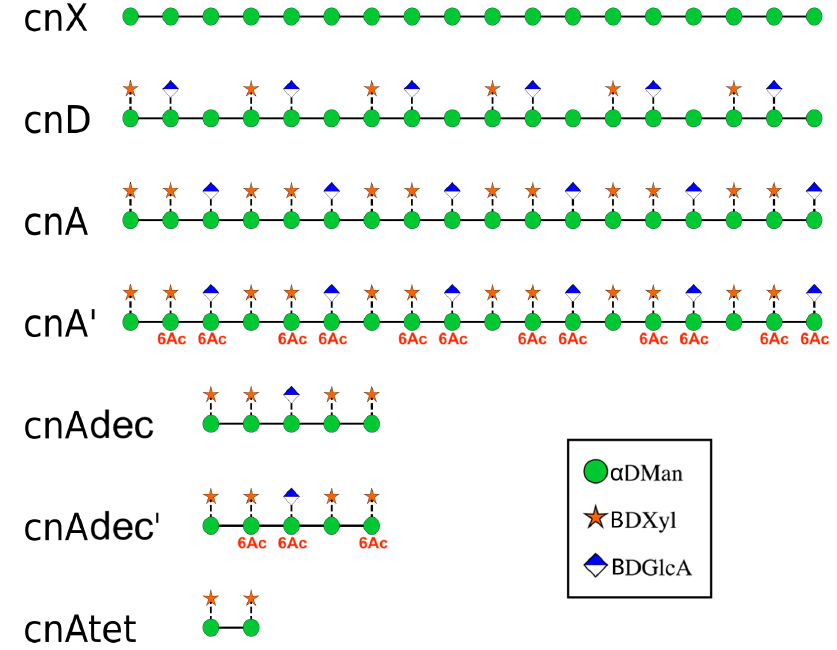
Figure 2. The array of GXM oligosaccharides simulated in this work, shown with the SNFG symbols [13,14] for the sugar residues. Six RUs of an unsubstituted backbone (cnX); the main repeat motifs in serogroup D (cnD) serogroup A (cnA) and 6- O -acetylated serogroup A (cnA’) were run in separate simulations; and three shorter strands of serogroup A GXM: a decasaccharide (cnAdec), a 6- O -acetylated decasaccharide (cnAdec’) and a tetrasaccharide